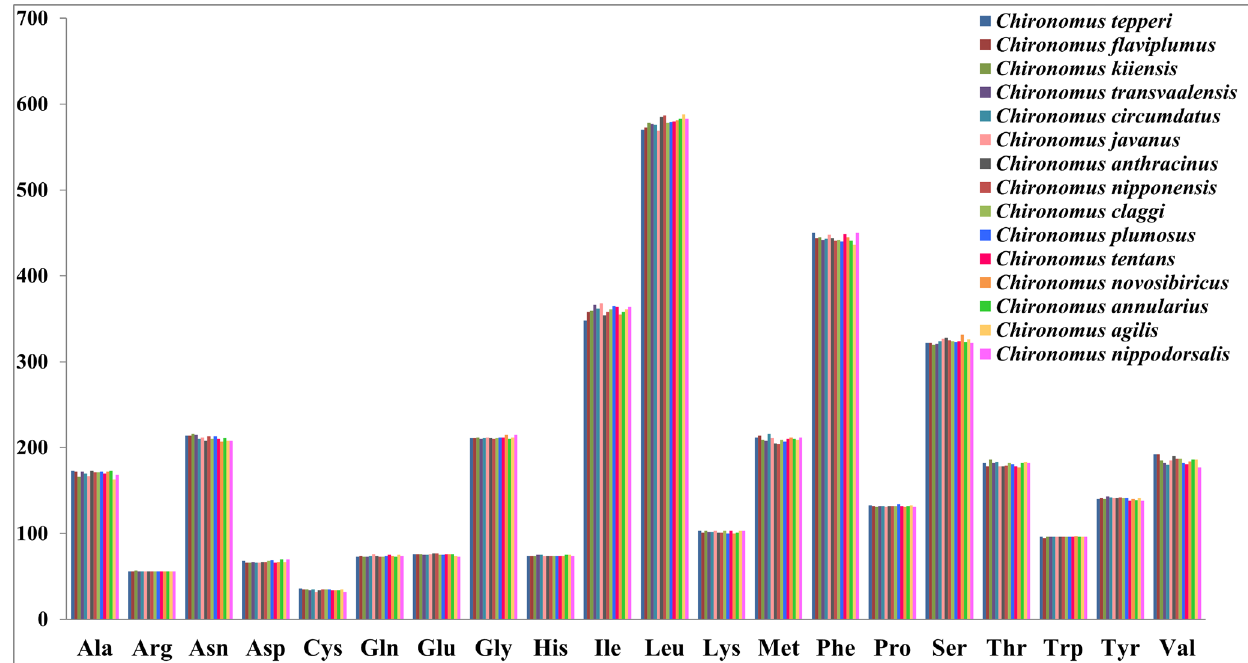
Figure 2. Amino acid distribution of mitogenomes of 15 Chironomus species. The x axis represents the codon families, and the y axis represents the total codon.